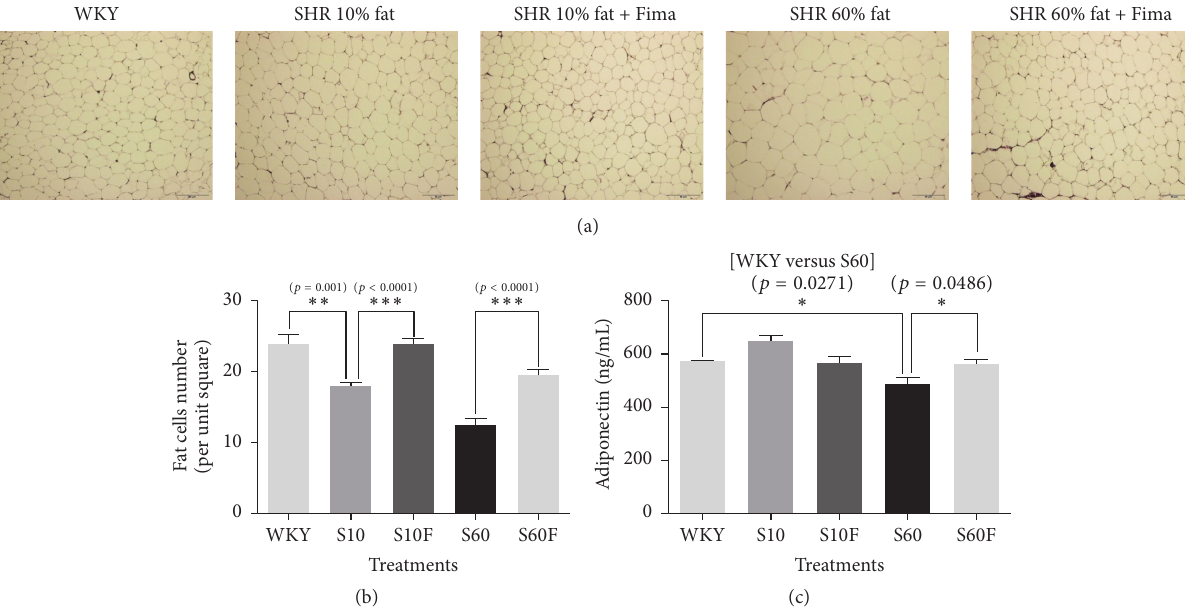
Figure 6: The number of adipocytes and adiponectin concentration in visceral fat tissues of WKY rats and SHRs given high-fat diet and fimasartan. (a) Fat tissue slides of WKY rats and SHRs were fixed and stained by hematoxylin and eosin reagents. Magnification is 100x. (b) The number of adipocytes per unit square (5461.06 𝜇 m 2 ) in slides stained by hematoxylin and eosin reagents. (c) The concentration of adiponectin in visceral fat extracts of WKY rats and SHRs was estimated with adiponectin colorimetric assay kit. The results are expressed as means ± SEM ( 𝑛 = 3 or 6). Values were statistically analyzed by unpaired t -test. All experiments were repeated three times. Meaning of indications: WKY means normal control rat given normal diet containing 10% fat, S10 means SHRs given normal diet containing 10% fat, S10F means SHRs given normal diet containing 10% fat plus fimasartan, S60 means SHRs given high-fat diet containing 60% fat, and S60F means SHRs given high-fat diet containing 60% fat plus